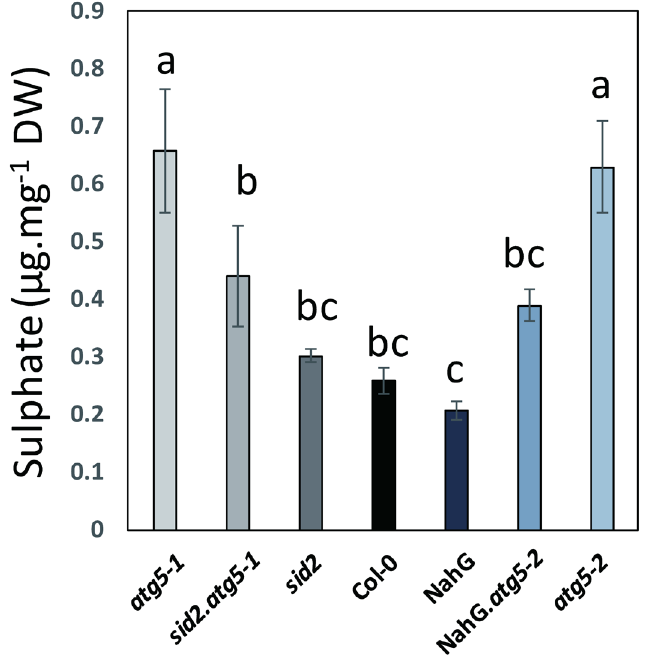
Figure 8. Sulphate concentrations in the rosette of atg5 autophagy mutants are significantly higher than in the rosettes of control lines under low S. Sulphate was measured on the dry remains of the rosettes at seed maturity. Data are the adjusted means and SD from six plant repeats The di ff erent letters indicate values significantly di ff erent at p < 0.05 (n = 6), as determined using an ANOVA Newman–Keuls (SNK) comparison.